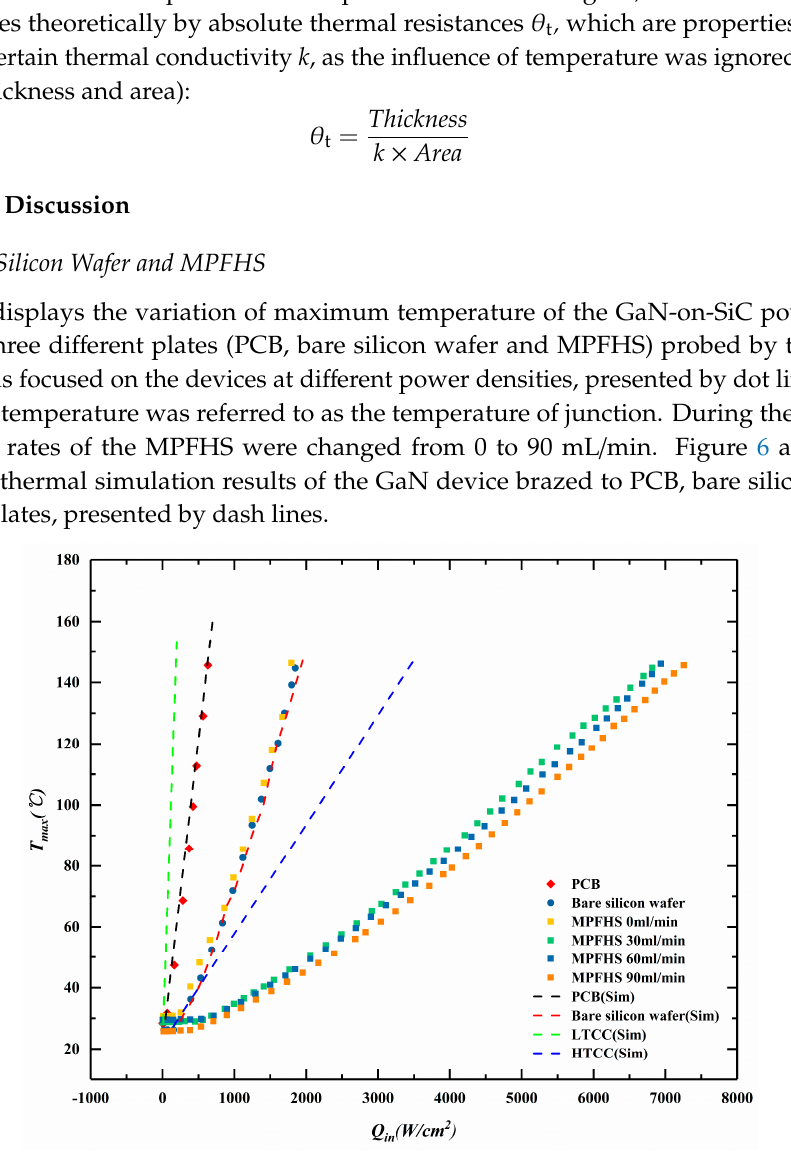
Figure 6. The maximum temperature of the GaN power amplifier mounted on three different plates (PCB, bare silicon wafer and MPFHS) as a function of dissipated power density probed by the IR camera system. During the experiments, the mass flow rates of the MPFHS were changed from 0 to 90 mL/min.